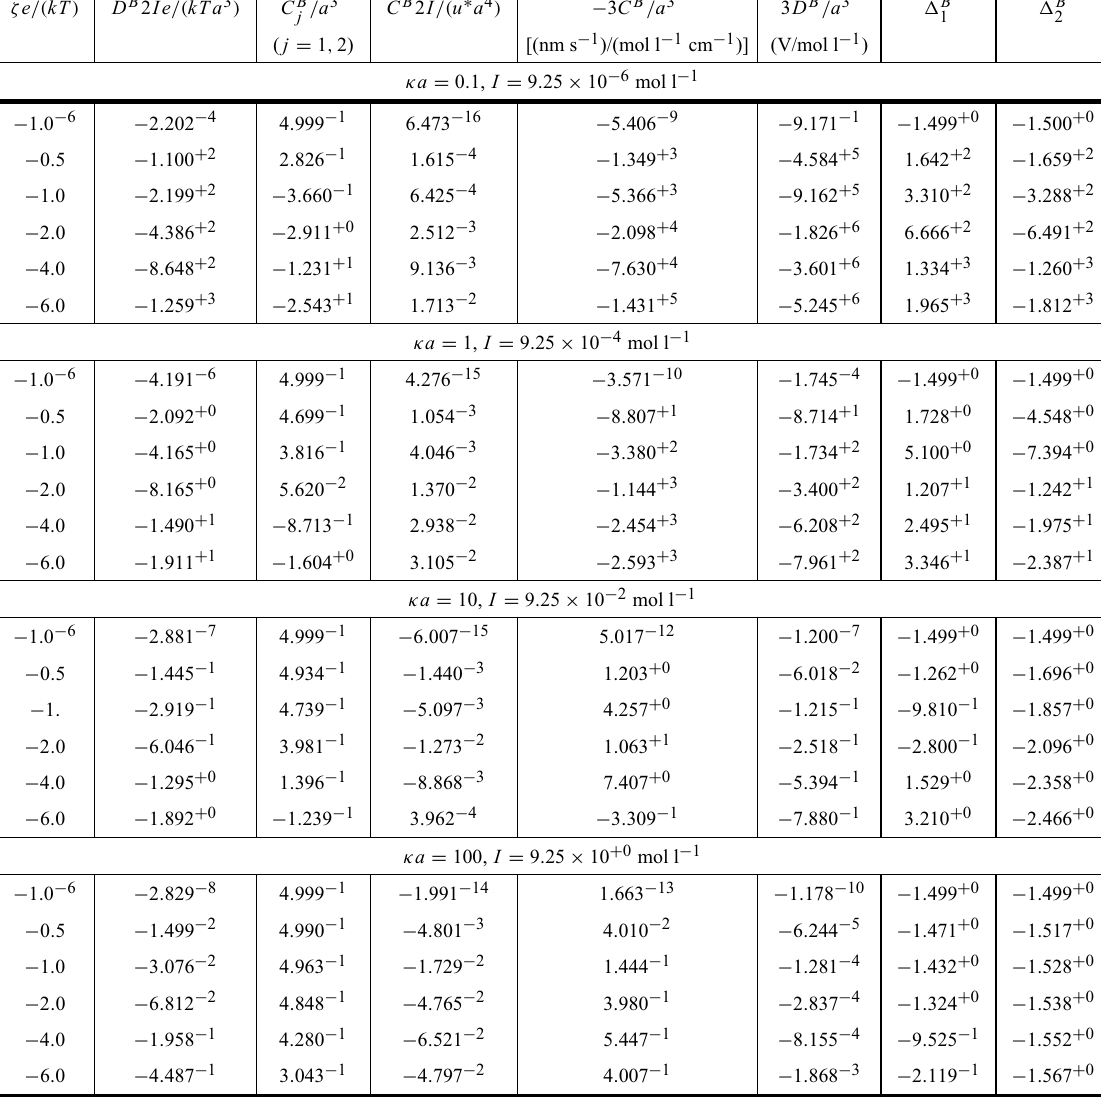
Scaled (dimensionless) asymptotic coefficients for bulk diffusion of NaCl in a Brinkman medium with charged spherical inclusions (see Hill 2006b, for details):